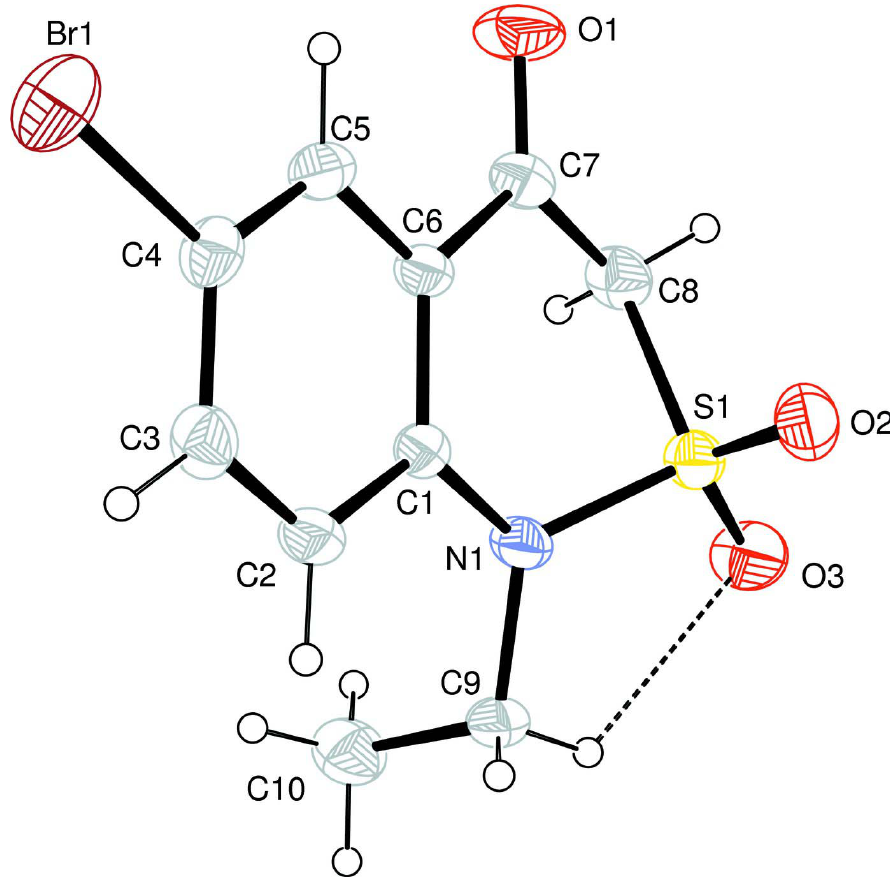
Figure 1 ORTEP drawing of the title compound, with the atom numbering scheme. The thermal ellipsoids are drawn at the 50% probability level. H atoms are shown by small circles of arbitrary radii. The dotted line shows the intramolecular